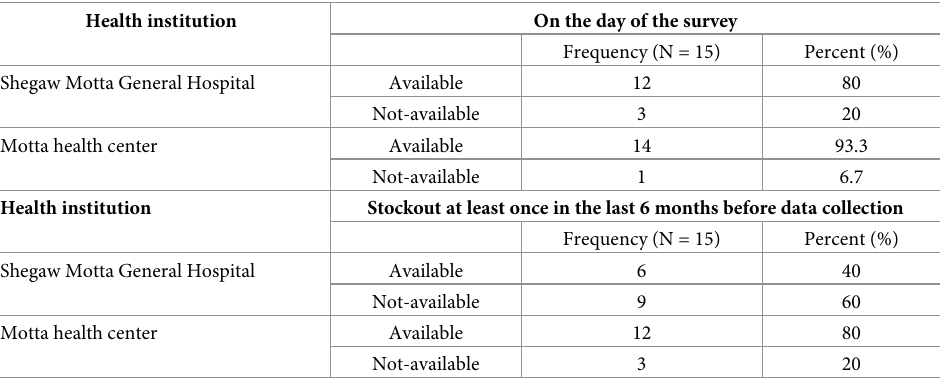
Table 2. Availability of essential medicines on the day of the survey and in the last 6-month before data collection.